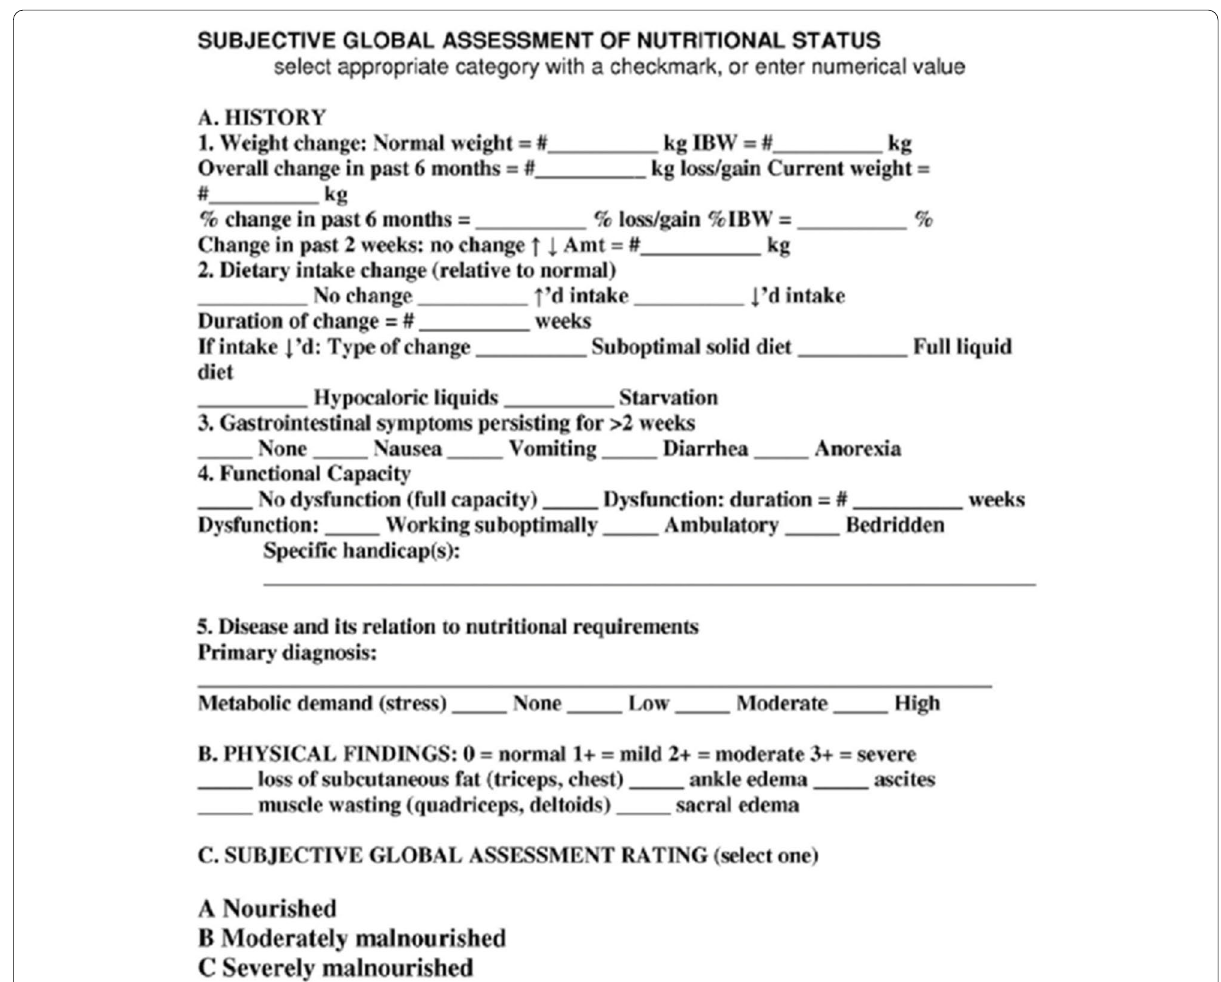
Fig. 1 A Mild protein-energy malnutrition: in adults, with BMI < 18.5 kg/m 2 or weight loss (5–9%), with mild subcutaneous fat loss and/or mild muscle wasting. B Moderate protein-energy malnutrition: in adults, with BMI < 18.5 kg/m 2 or weight loss (5–9%), with moderate subcutaneous fat loss and/or moderate muscle wasting. C Unspecified severe protein-energy malnutrition: In adults, BMI < 18.5 kg/m 2 or weight loss ( severe subcutaneous fat loss and/or severe muscle